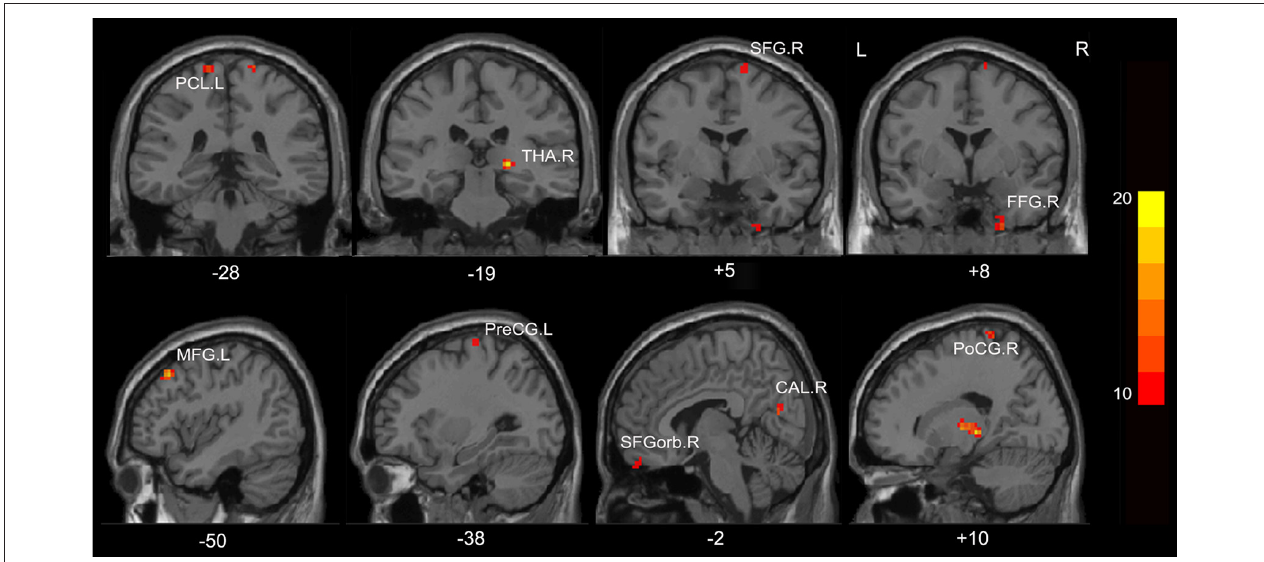
FIGURE 1 | Regions showing significantly different regional homogeneity (ReHo) across the three groups ( p < 0.05, false discovery rate (FDR) corrected). FFG, fusiform gyrus; SFGorb, superior frontal gyrus, orbital part; PoCG, postcentral gyrus; PreCG, precentral gyrus; THA, thalamus; CAL, calcarine; SFG, superior frontal gyrus; PCL, paracentral lobule; MFG, middle frontal gyrus; R, Right; L, Left. The color bar indicates a scale of T values.